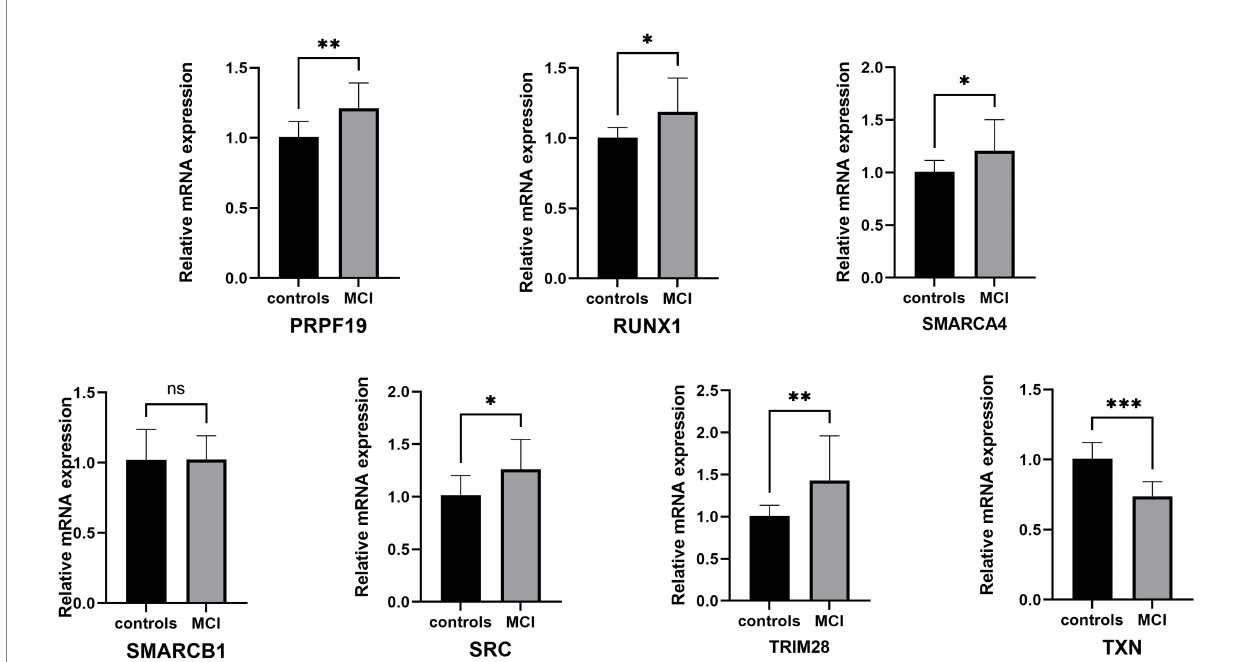
FIGURE 11 QRT-PCR validation of the hub genes between controls and MCI. The data were expressed as mean ± SEM (short for standard error of mean). * p < 0.05, ** p < 0.01, *** p < 0.001, **** p < 0.0001, ns means no significance.